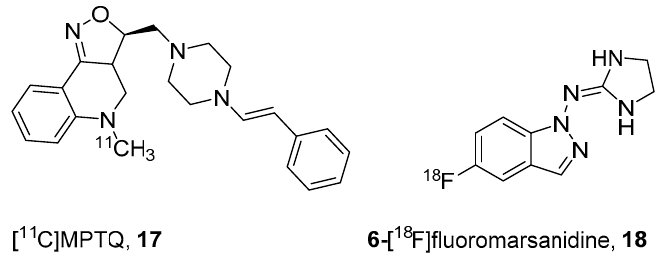
Figure 5. α 2A-antagonist ( 17 ) and agonist ( 18 ) PET radiotracers.